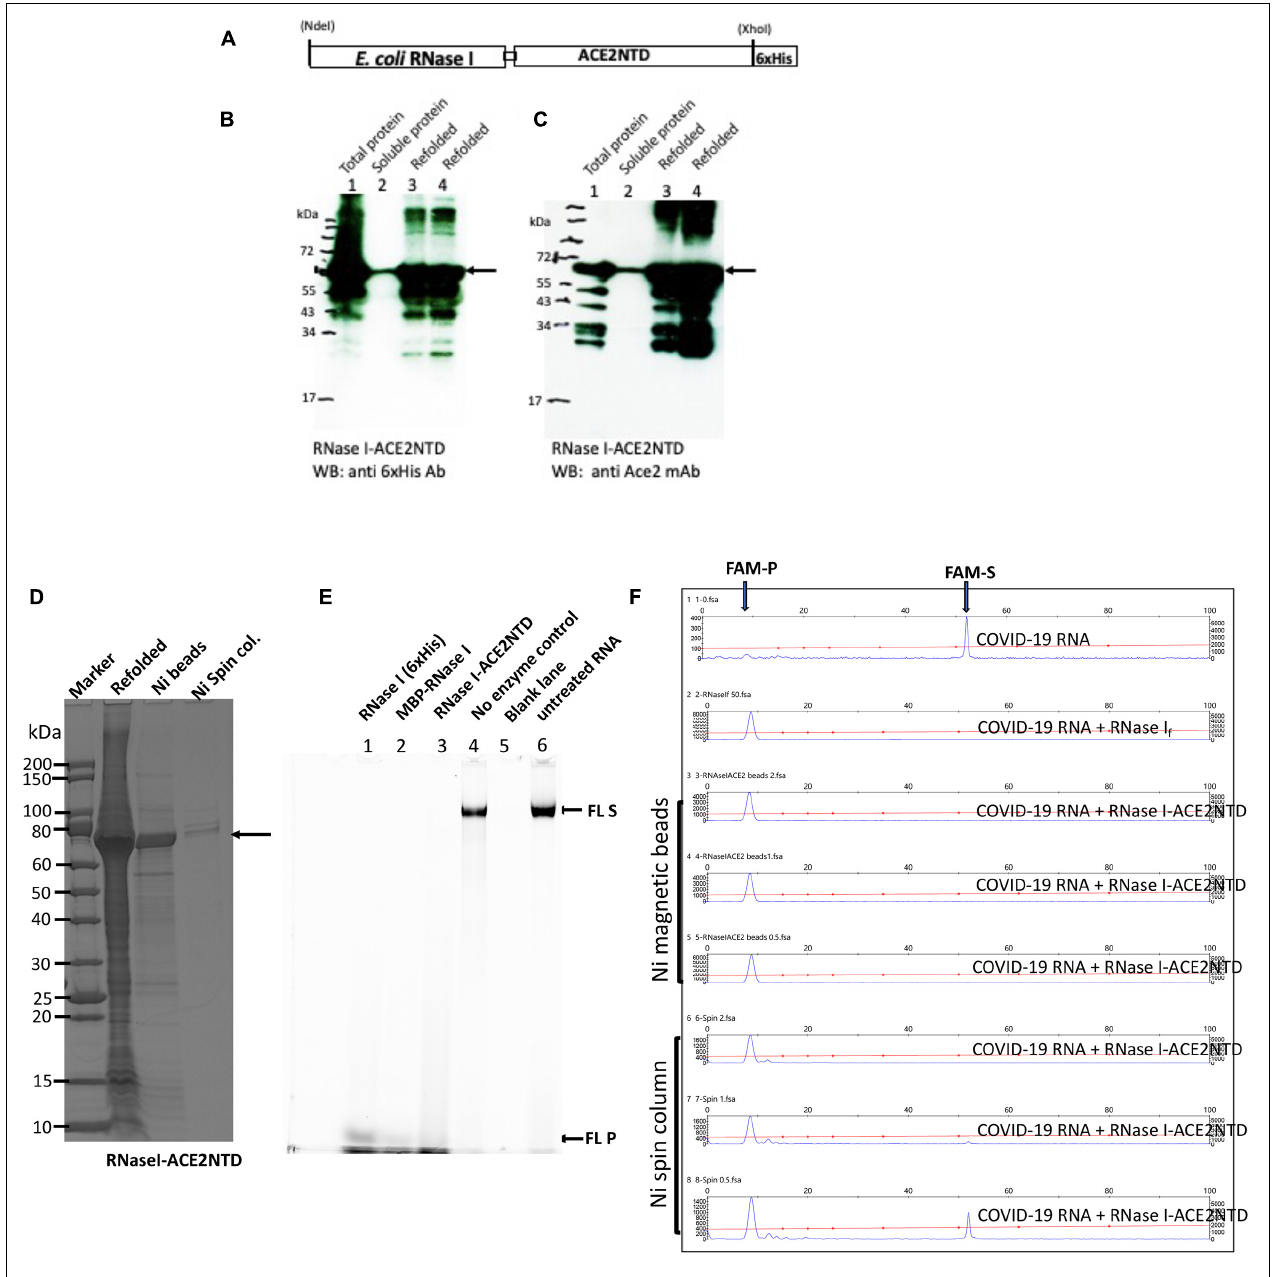
FIGURE 5 | SDS-PAGE and Western blot analysis of RNase I-ACE2NTD fusion and activity assays. (A) Schematic diagram of RNase I-ACENTD (6 × His) fusion. (B) Western blot analysis of RNase I-ACE2NTD in total protein, supernatant (soluble), and refolded protein using anti-His mAb. (C) Same as in (B) , except using anti-ACE2 mAb. (D) SDS-PAGE analysis of the refolded RNase I-ACE2NTD fusion and further purified protein by Ni magnetic beads and Ni spin column. (E) RNase I-ACE2NTD (refolded) ribonuclease activity on fluorescein (FL)-labeled RNA (300 nt) in NEB buffer 3. RNase I (6 × His) and MBP-RNase I were used as positive controls. (F) Ribonuclease activity of RNase I-ACE2NTD (purified by Ni magnetic beads or Ni spin column) on SARS-CoV-2 RNA (50 mer). RNase I f , a positive control. FAM-S, FAM-labeled substrate; FAM-P, FAM labeled cleavage